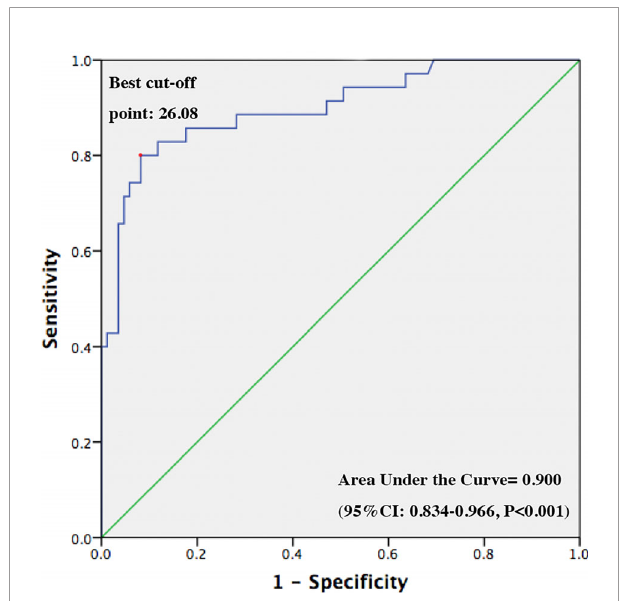
FIGURE 4 | ROC curve for predicting postoperative hypothalamic obesity using preoperative